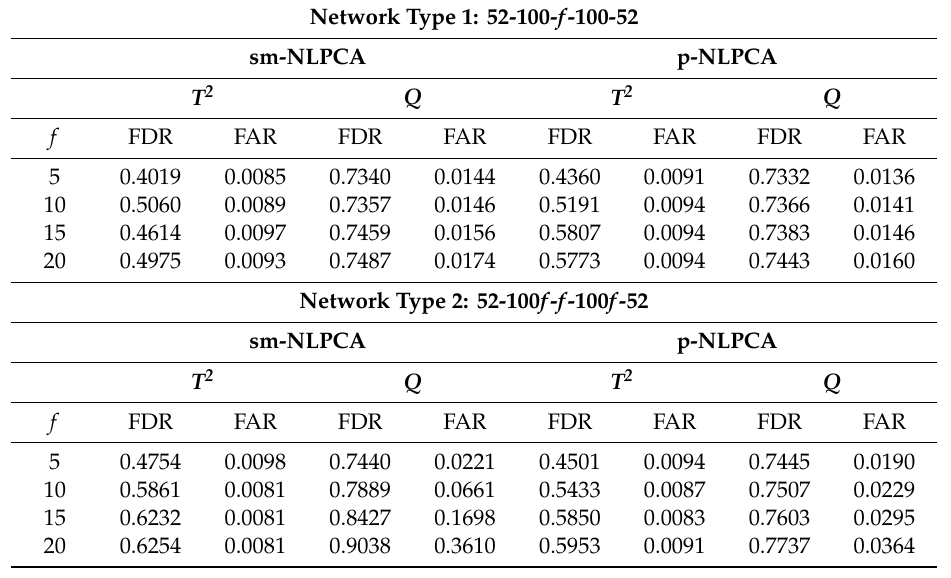
Table 4. Process monitoring results with varying the neural network size (with five layers).